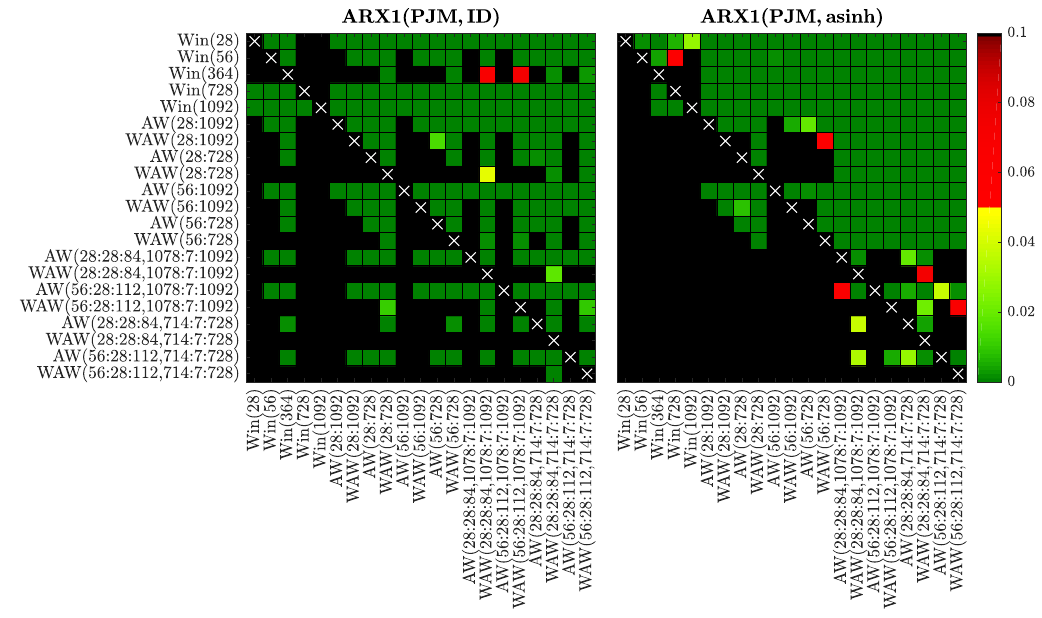
Figure 10. Results of the CPA test for selected window sets and the ARX1 model fitted to raw ( left ) or asinh -transformed ( right ) PJM data. We use a heat map to indicate the range of the p -values—the closer they are to zero ( → dark green) the more significant is the difference between the forecasts of a set on the X -axis (better) and the forecasts of a set on the Y -axis (worse).